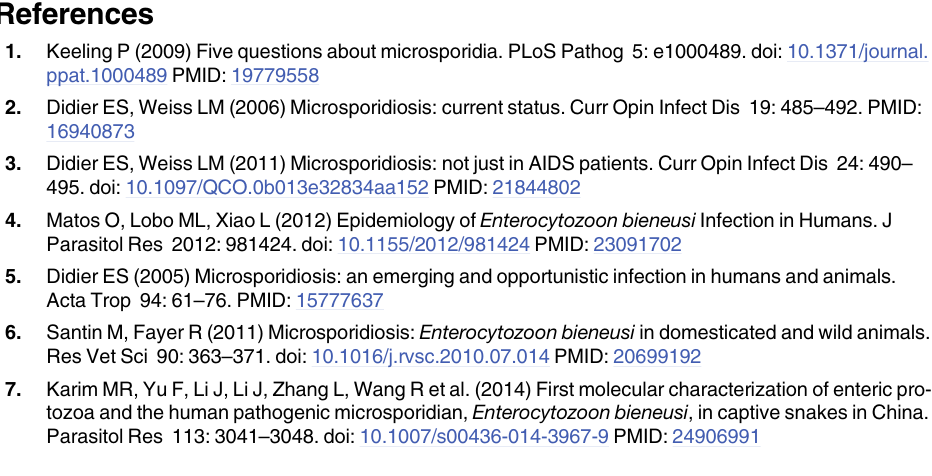
S1 Table. Information of E . bieneusi